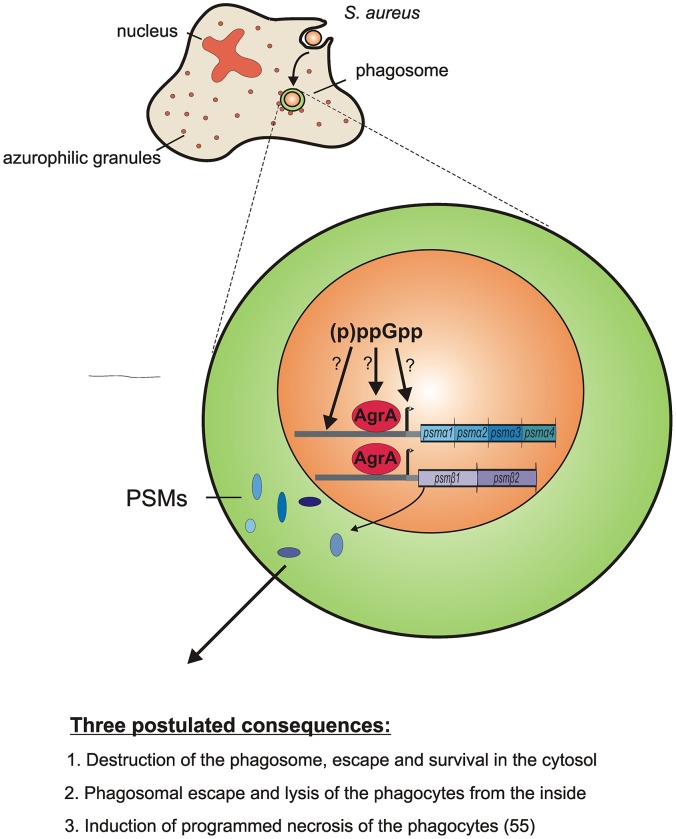
Overview of the presumed impact of the stringent response on survival after phagocytosis.The induction of the stringent response (pppGpp) in phagocytosed bacteria leads to increased psms expression. The PSMs in turn mediate a pronounced survival after phagocytosis, most likely through phagosomal escape or intracellular lysis of the phagocytes.